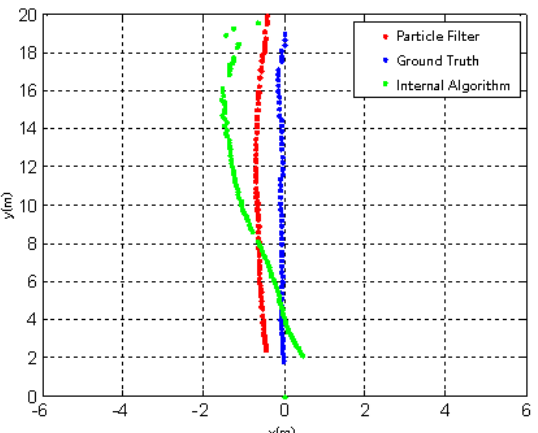
Figure 5. Estimated trajectories of moving objects using different methods.